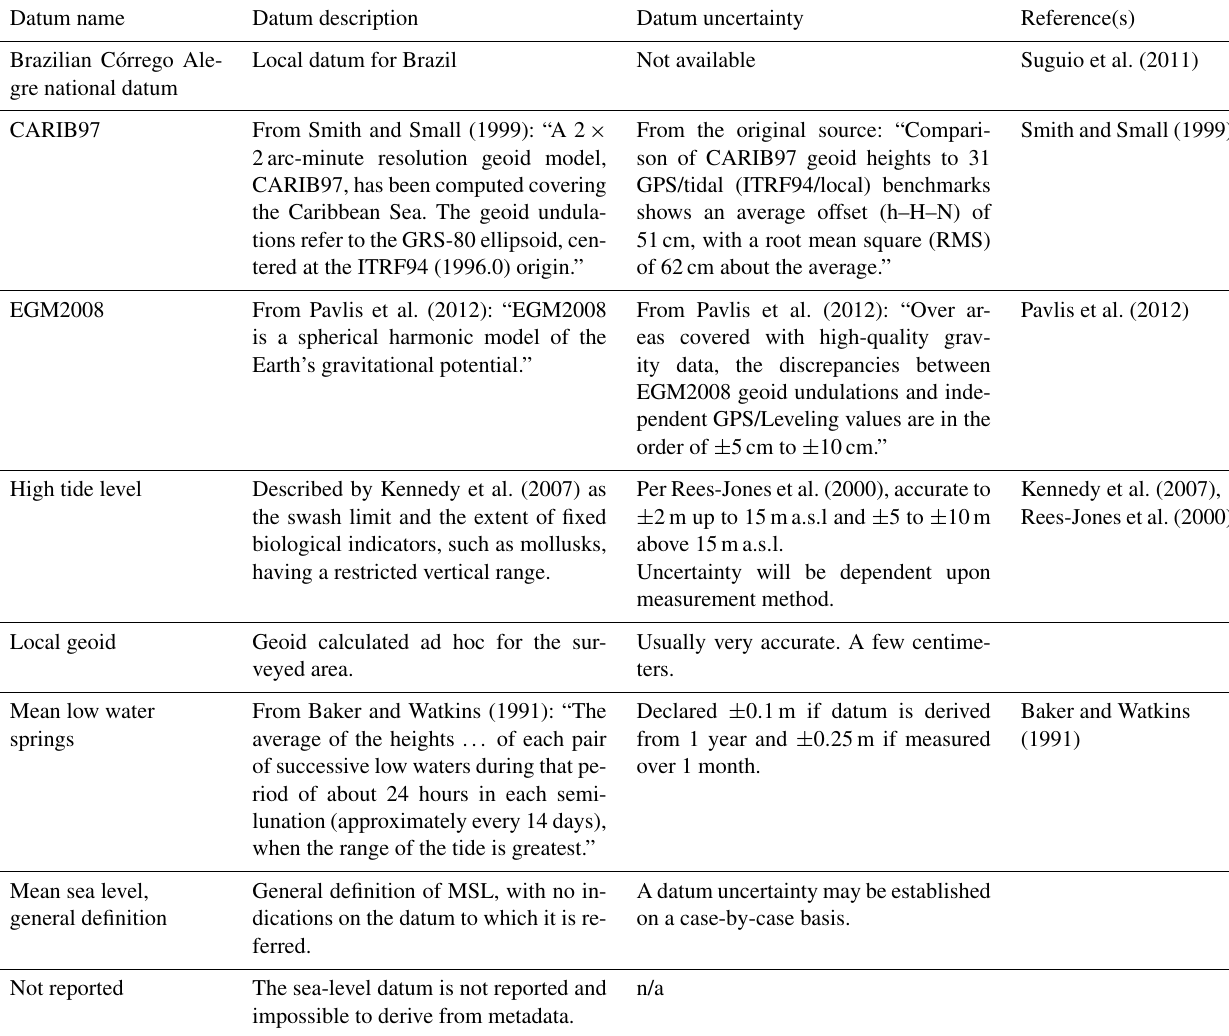
Table 2. Elevation